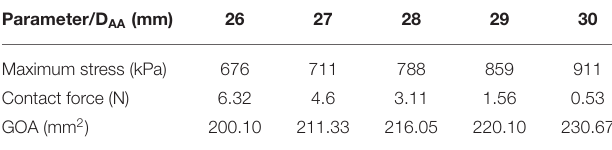
TABLE 1 | Parameter values of the model with a valve height of